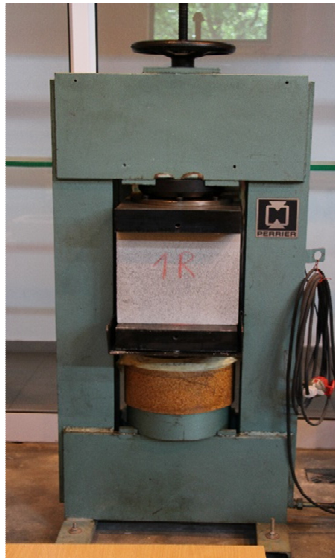
Figure 8. Course of strength testing–compression of a block in a hydraulic